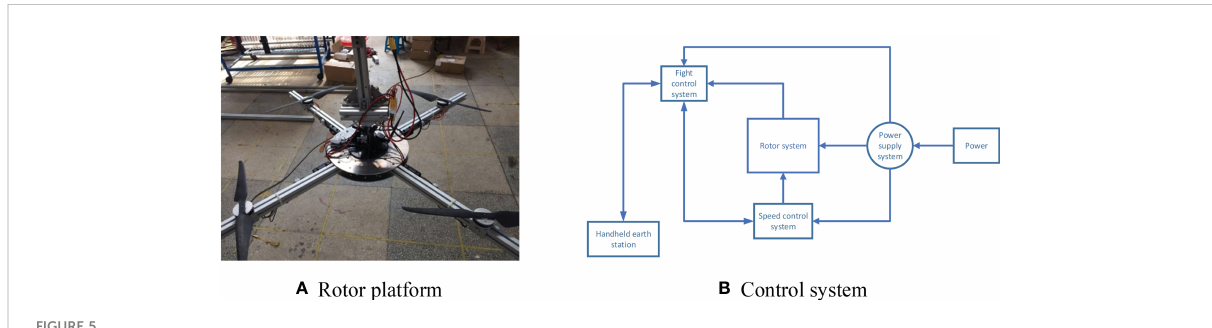
FIGURE 5 Plant protection UAV test